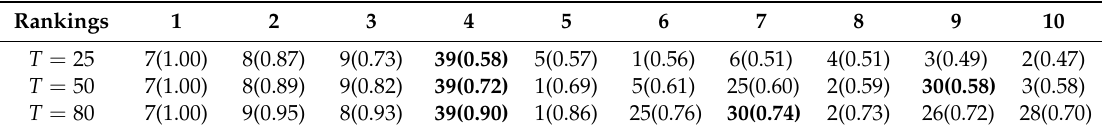
Figure 5. Dynamic critical nodes and regions identification results for case A. ( a ) the critical nodes; ( b ) the critical regions. Table 1. Top 10 critical nodes with their importance score in case A.